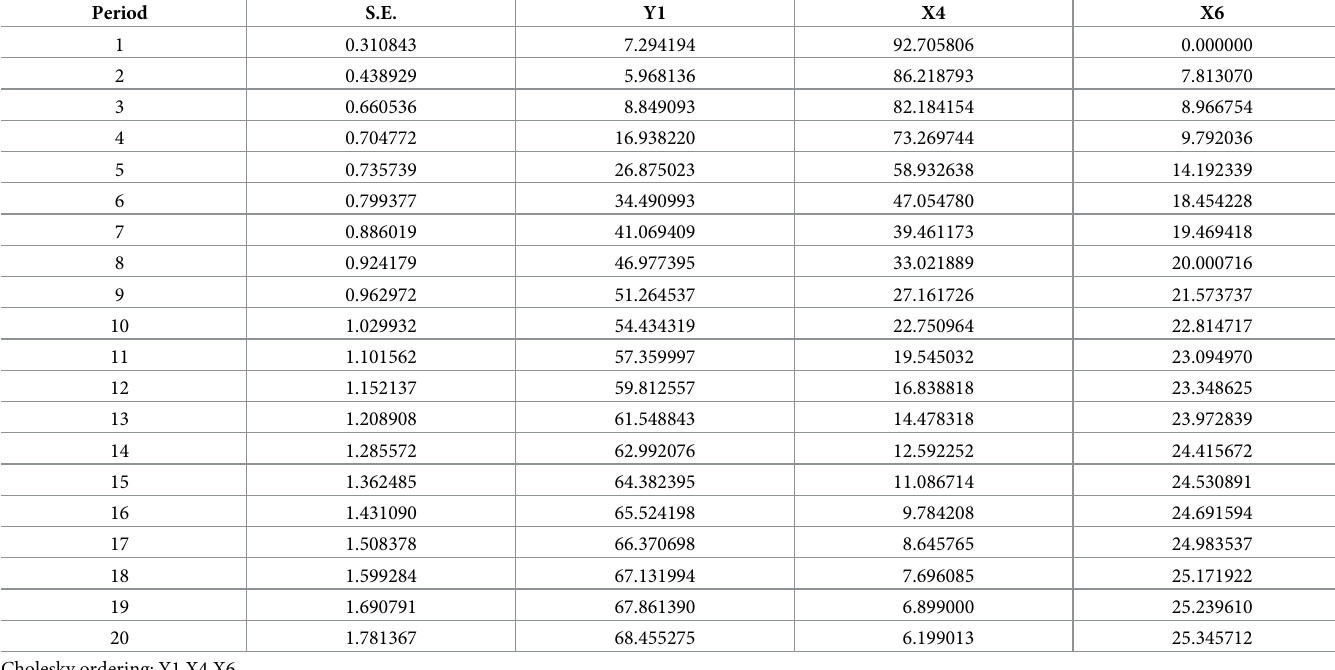
Table 9. Variance decomposition of X 4